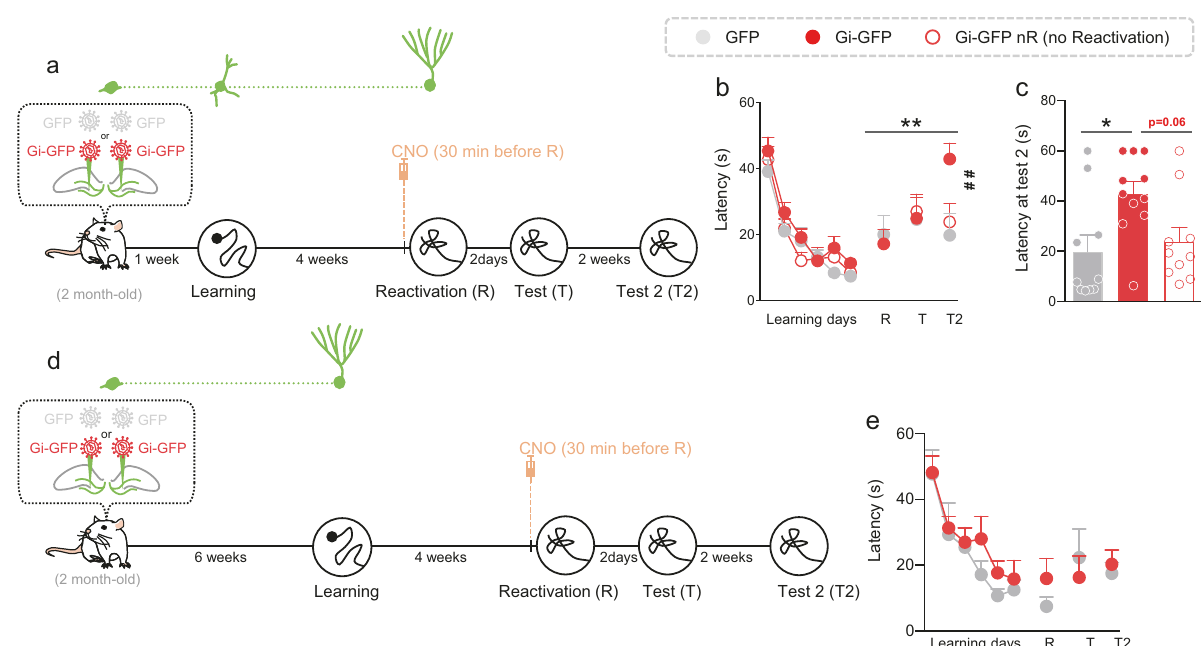
Fig. 5 Silencing during reconsolidation, neurons that were immature at the time of learning, impairs long-term memory persistence whereas silencing neurons that were mature at the time of learning had no impact on memory. a Experimental protocol: 2-month-old rats were injected with Gi-GFP RV ( n = 21) or its control GFP RV ( n = 10) 1 week before MWM training. Rats were trained for 6 days and memory was reactivated 4 weeks later GFP RV ( n = 10) and Gi-GFP-RV ( n = 11). Thirty minutes before reactivation, CNO (1 mg/kg) was injected (i.p.). A group of rats Gi-GFP-RV ( n = 10) received CNO but was not reactivated (nR). Memory was tested 2 days later (Test) and again 2 weeks later (Test 2). b Latency to fi nd the platform during training and to fi rst cross the position of the platform during the reactivation and test trials. Memory performances of Gi-GFP rats were impaired at Test 2 compared to those of GFP RV rats and compared to their own performances at the reactivation trial (Tukey ’ s test: ** p < 0.01; ## p < 0.01). c Latency to cross the position of the platform at Test 2. Latency was higher for the Gi-GFP rats compared to that of GFP rats (Tukey ’ s test: * p < 0.05). d Experimental protocol: 2-month-old rats were injected with Gi-GFP RV ( n = 11) or its control GFP RV ( n = 6) 6 weeks before MWM training. Rats were trained for 6 days and memory was reactivated 4 weeks later. 30 min before reactivation, rats were injected (i.p.) with 1 mg/kg CNO. Memory was tested 2 days later (Test) and